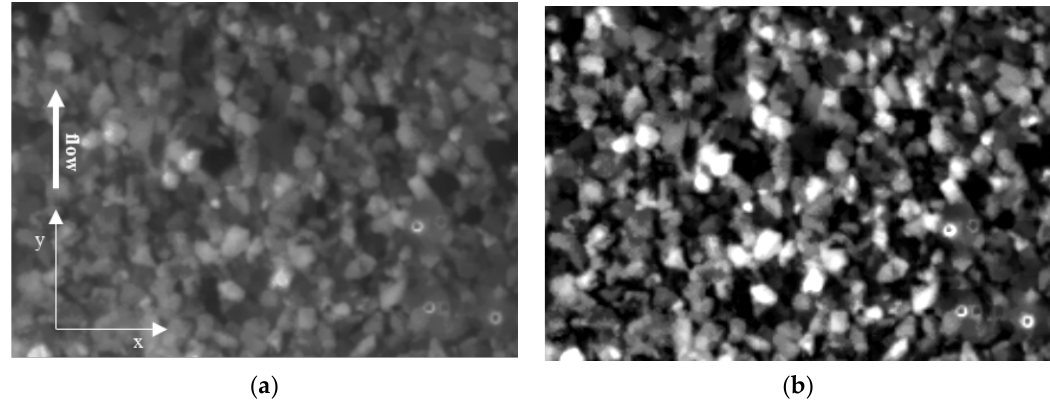
Figure 2. ( a ) Raw image and ( b ) pre-processed image.